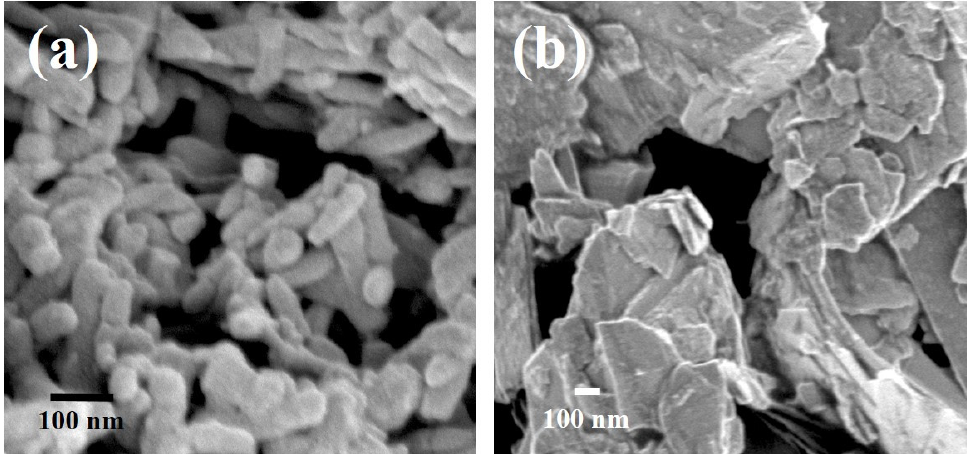
Figure 1. SEM micrographs of ( a ) as-synthesized PANI nano-rods and ( b ) as-received MoS 2 nanosheets.